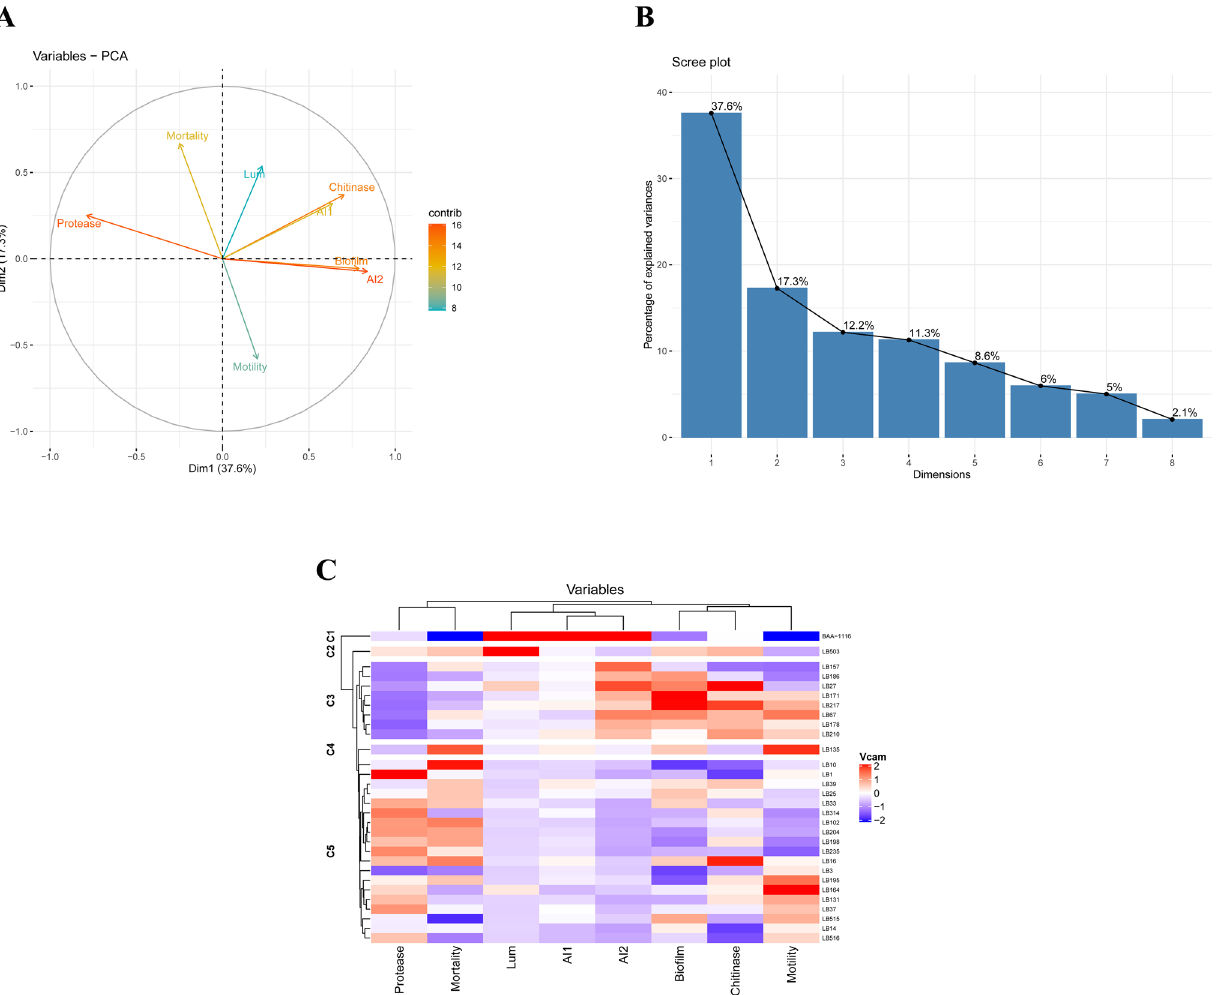
Figure 6. Principal component and cluster analysis of virulence factors and pathogenicity. ( A ) Principal component analysis. Dim1, First principal component; Dim2: second principal component; Lum: Luminescence; AI-1: Autoinducer-1; AI-2: autoinducer-2. ( B ) Scree plot showing the first three dimension for most of the cumulative variability in data represented by the eigenvalues ( C ) Hierarchical clustering analysis with the heatmap. The red to blue transition indicates a higher to a lower